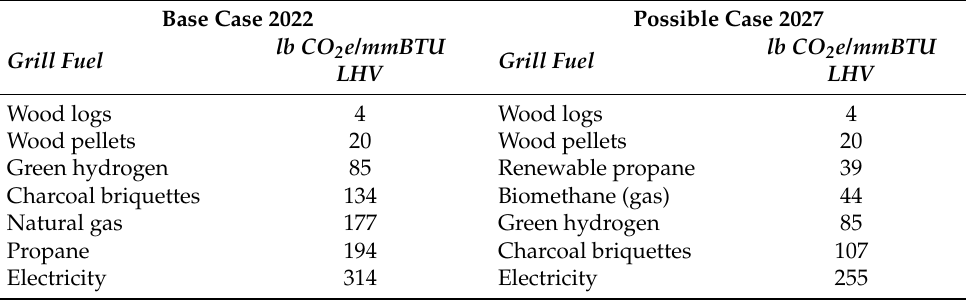
Figure 3. Carbon footprints for grills, fuel-only by life-cycle stage, USA 2022. Using the same method as for 2022, possible footprints were calculated for 2027 (Table 7). They are presented alongside the 2022 ones for comparison. Table 7. Carbon footprint rankings, by fuel, 2022 base case vs. alternative 2027